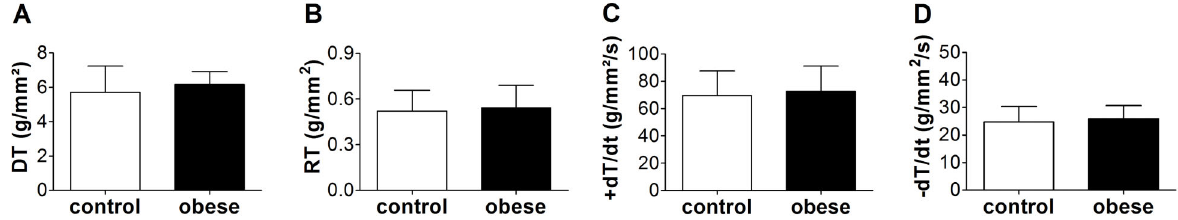
Figure 1. Basal evaluation of myocardial function in papillary muscles from control (n=11) and obese (n=11) rats. A , DT: maximum developed tension; B , RT: resting tension; C , + dT/dt: peak of positive tension derivatives; D , – dT/dt: peak of negative tension derivatives. Data are reported as means ± SD. Student ’ s t -test for independent samples was used to compare